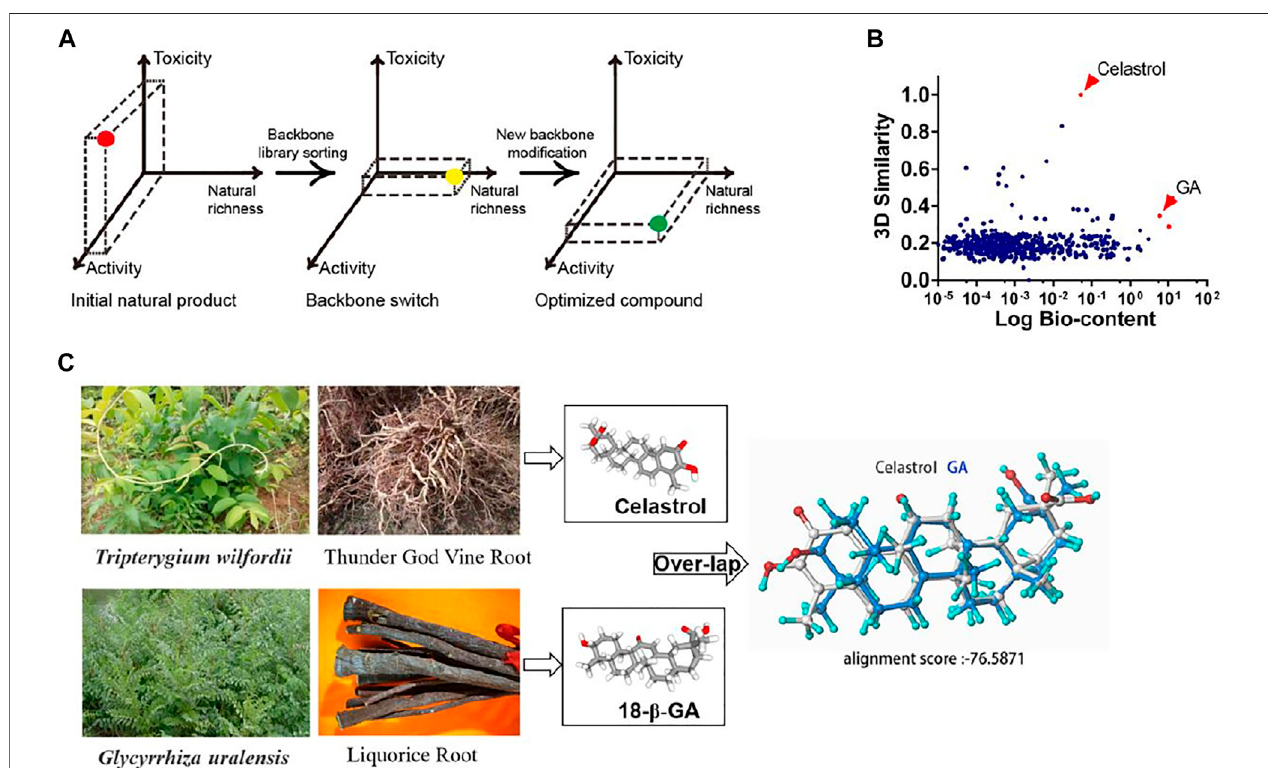
FIGURE 1 | Scaffold similarity search: from celastrol to GA. (A) Schematic diagram of the similarity search strategy. (B) Scatter diagram analysis of a pool of 1,380 triterpenoids. The x axis represents the logarithmic value of the triterpenoids bio-content (published % w/w in their respective herbal drugs of origin). The y axis corresponds to the computed structural similarity score relatively to celastrol. (C) The plant source and stero-structure of celastrol and GA.